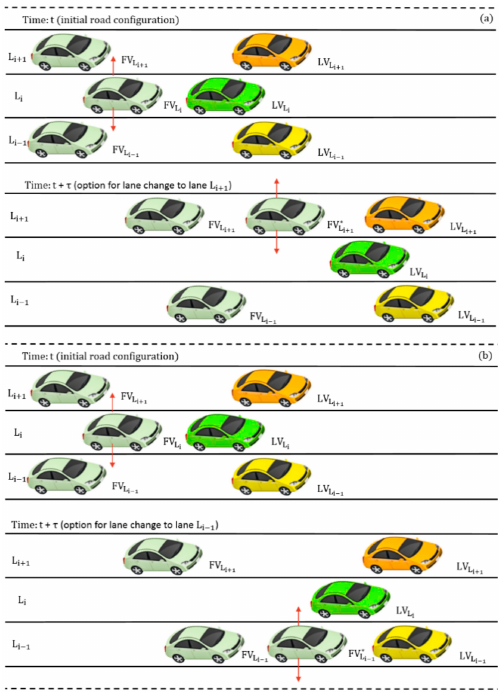
Figure 2. Lane change behavior: ( a ) movement of FV L movement of FV L from lane L i to lane L i − 1 at time t + τ i